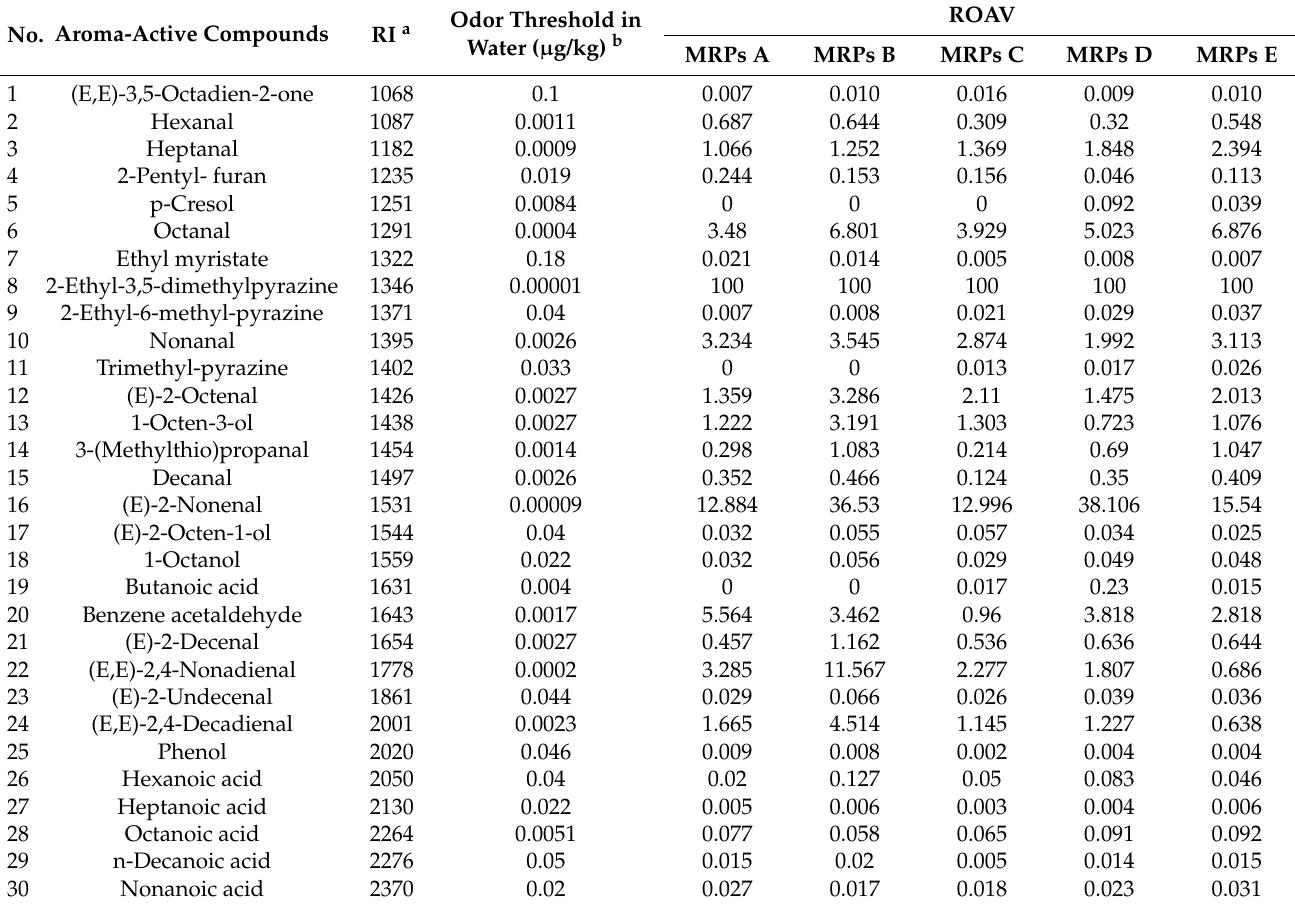
Table 3. Relative odor activity values of aroma-active compounds in